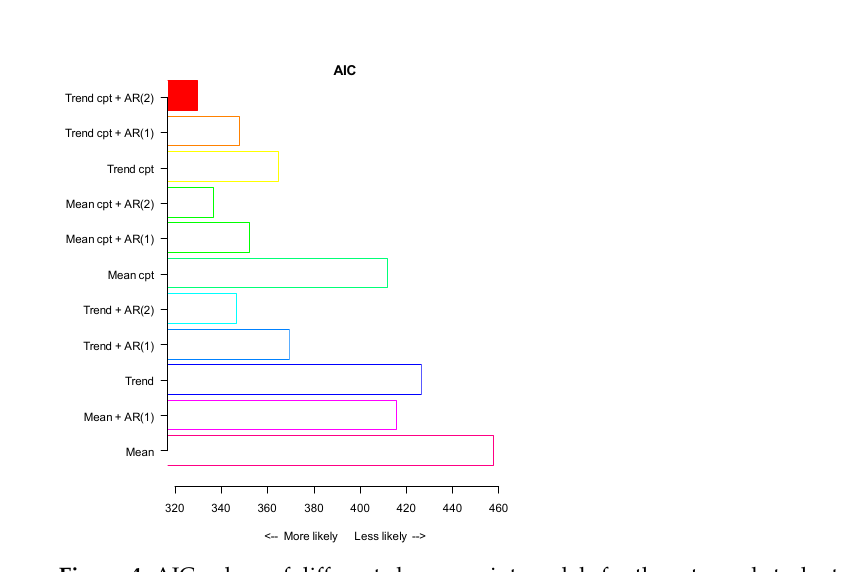
Figure 4. AIC values of different change-point models for the returned students.